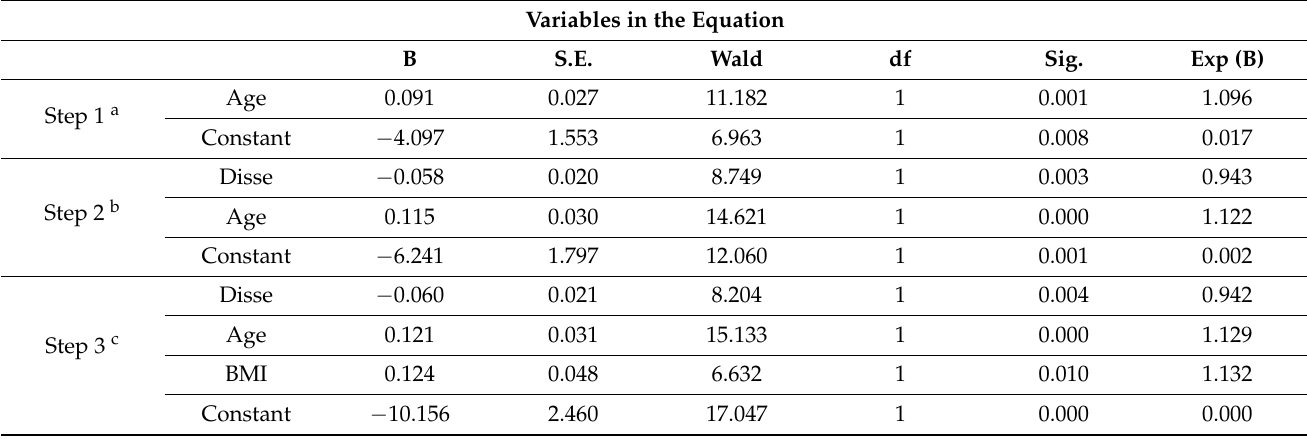
Table 5. Metabolic predictors of the combined endpoint (poor outcome or length of stay > 10 days) in binary logistic